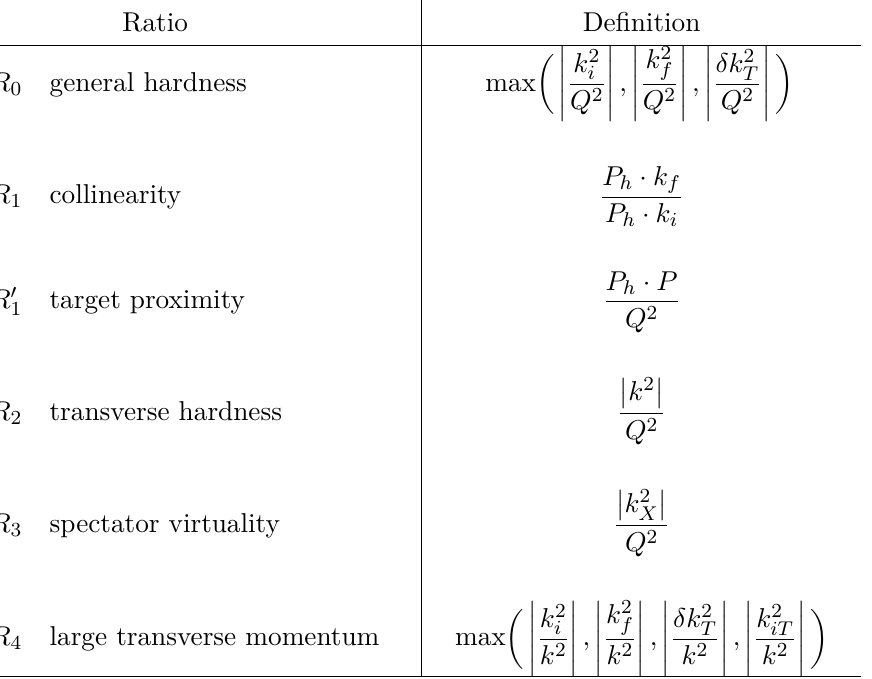
Table 1 . Summary of the diagnostic ratios and their definitions used for identifying different fragmentation regions in SIDIS. The particle momenta are defined as in figure